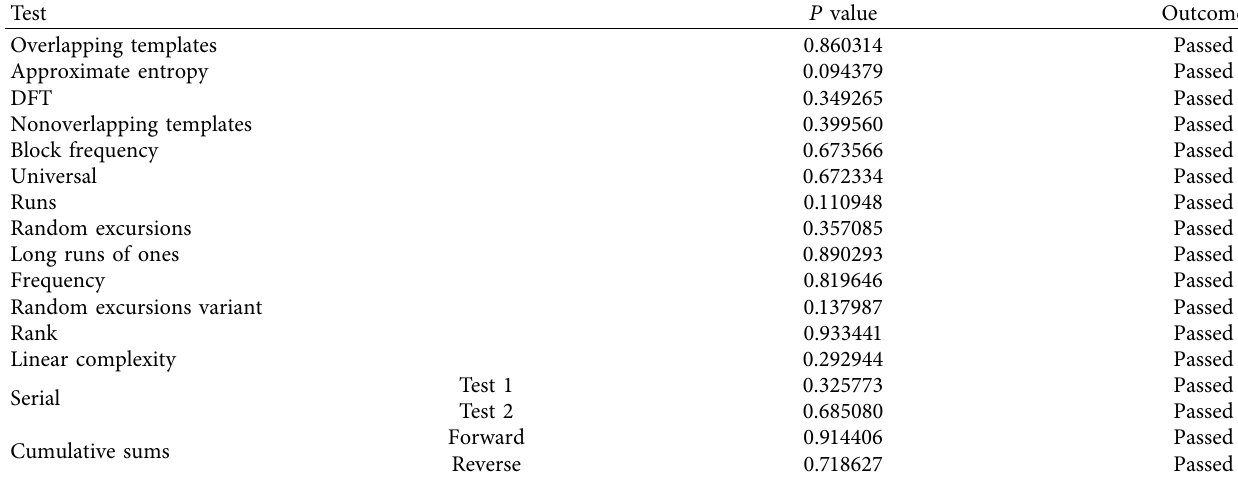
Figure 12: Occlusion attacks. (a–c) Ciphered version of composite image (Figure 4(b)) with cut-out occlusions covering 10%, 25%, and 25% of its content. (d–f) Recovered versions of the occluded images. Table 7: Outcomes of randomness test for the cipher composite image (Figure 4(b)).